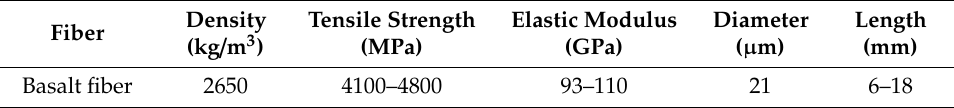
Table 4. The physical and mechanical properties of basalt